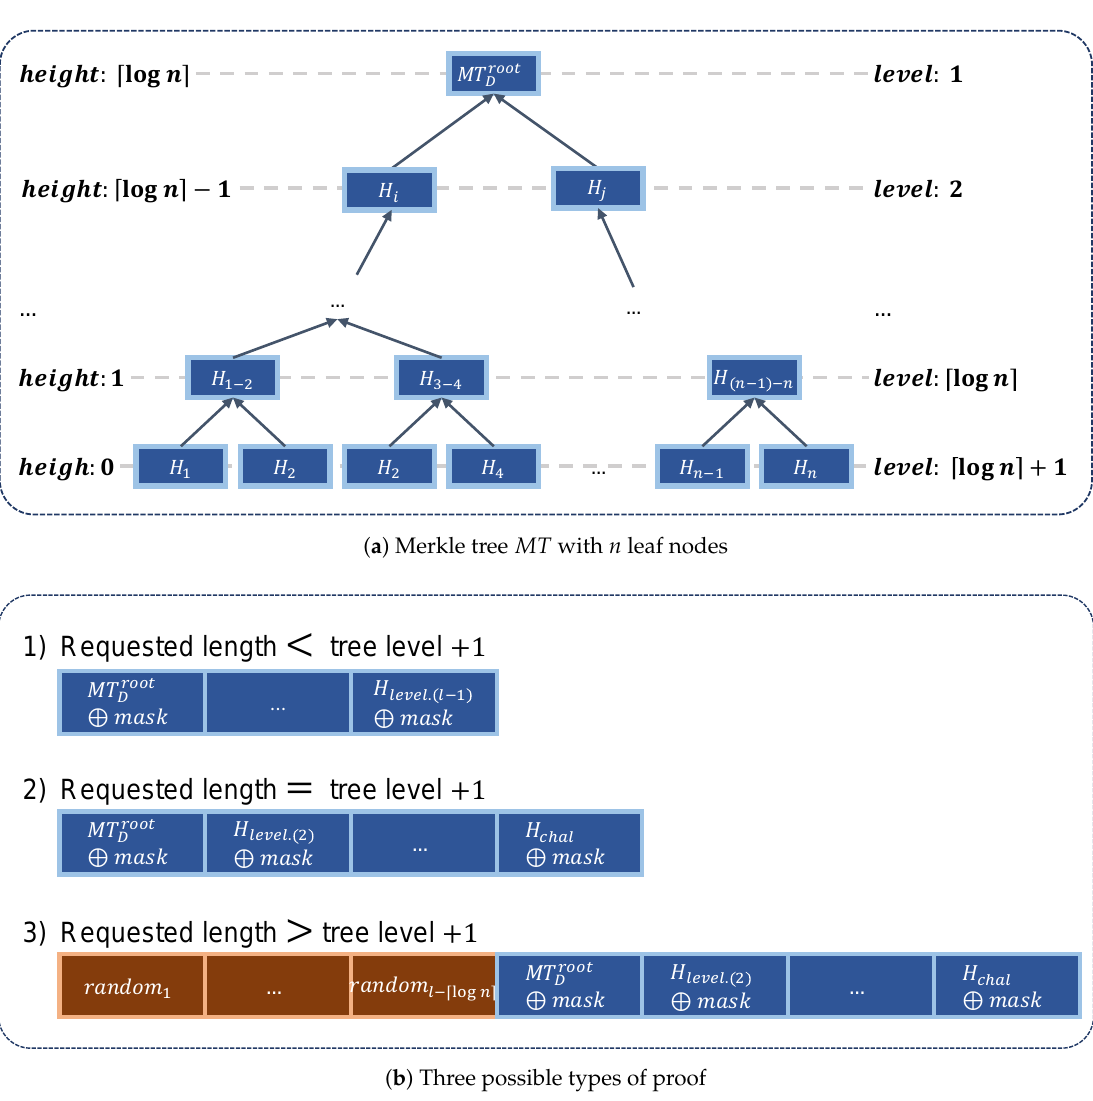
Figure 4. Classification of the proofs in the proposed